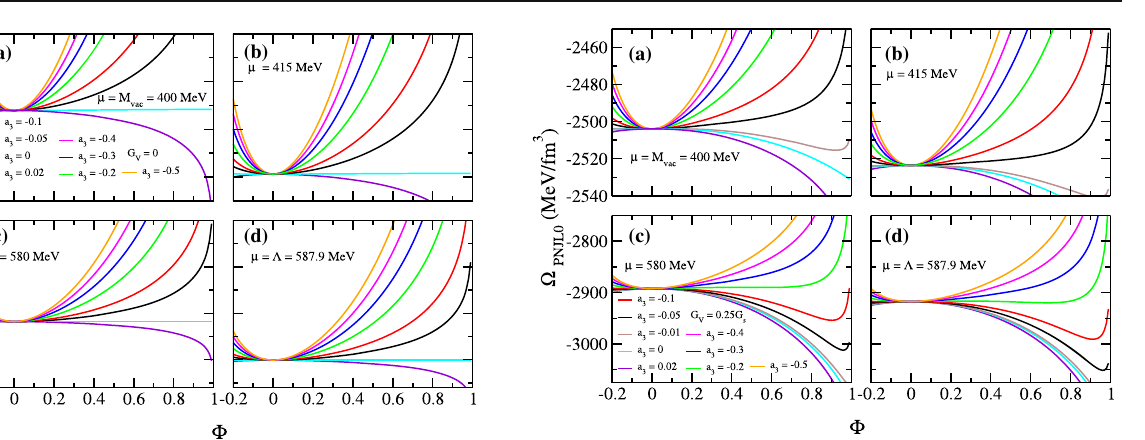
Fig. 1 Ω PNJL0 × Φ for G V = 0 with different values of a 3 . For each panelthequarkchemicalpotentialisgivenby a μ = M vac = 400 MeV, b μ = 415 MeV, c μ = 580 MeV, and d μ = Λ = 587 . 9 MeV